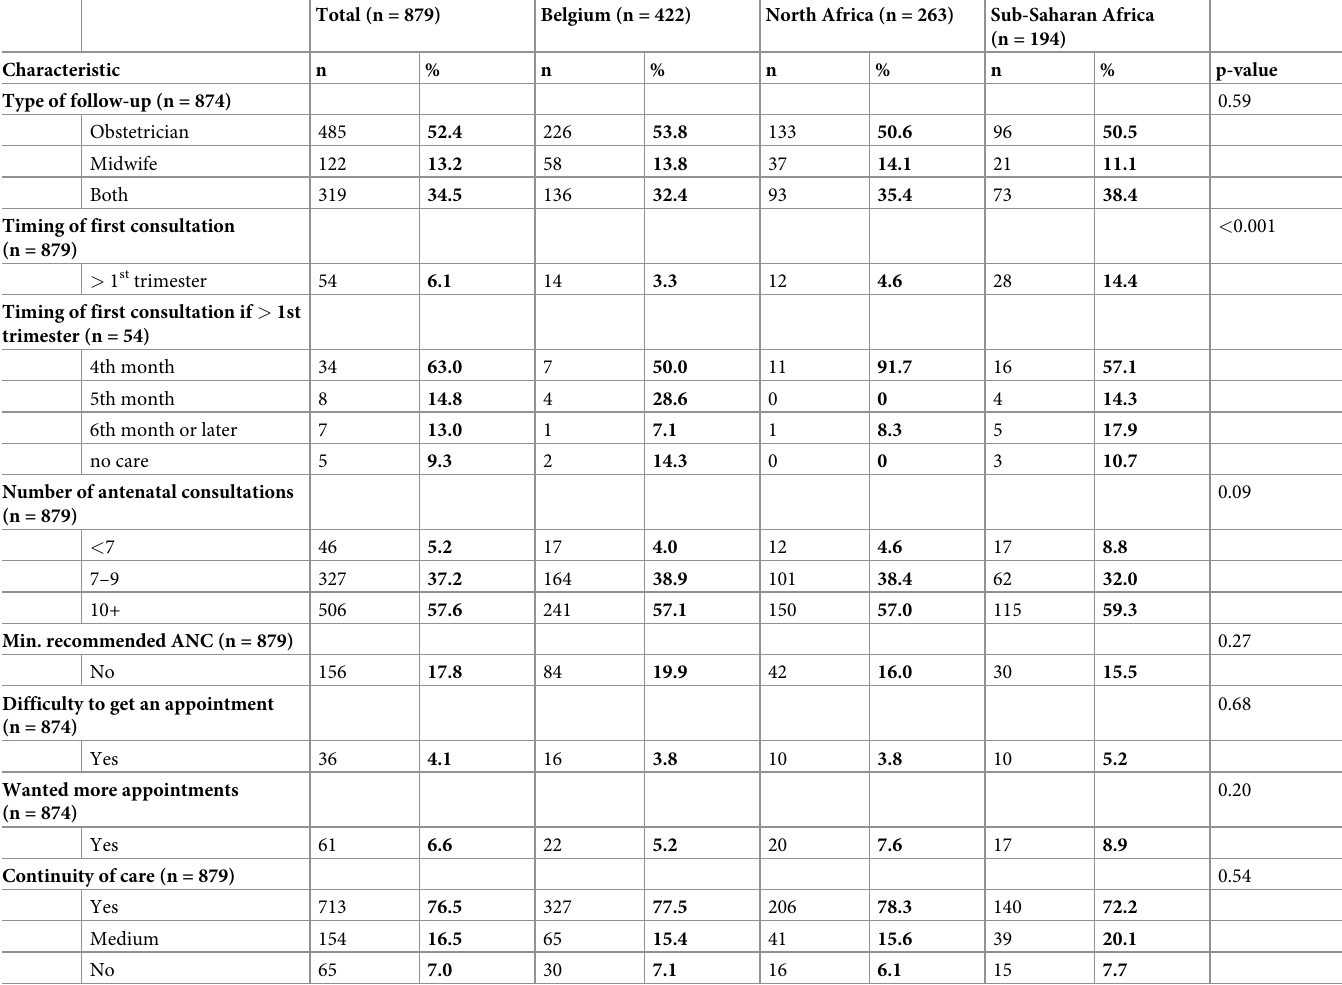
Table 2. Antenatal care characteristics, overall and by region of birth, with X 2 p-values. Total (n =